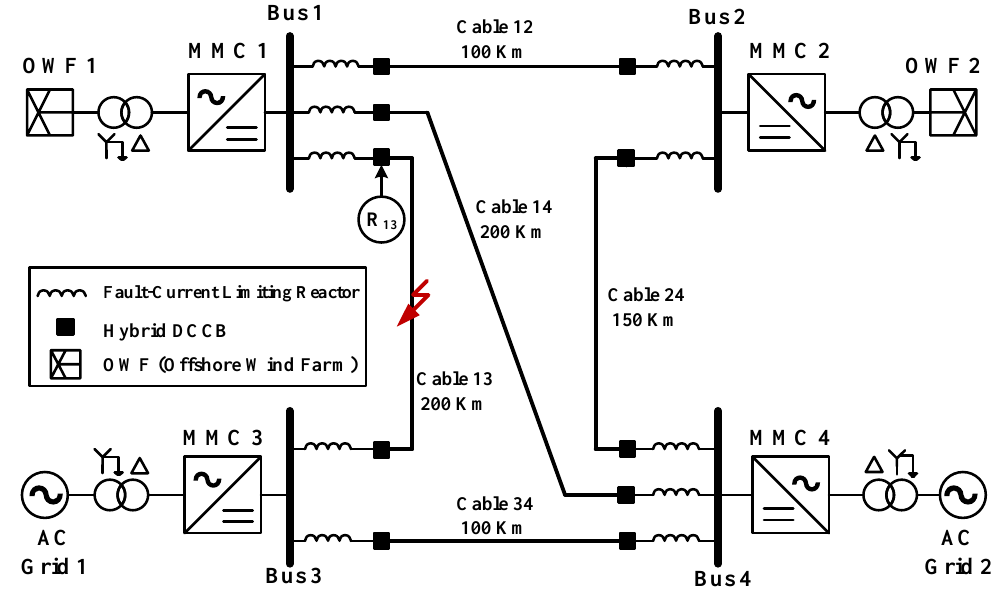
Figure 1. Four-terminal HVDC test